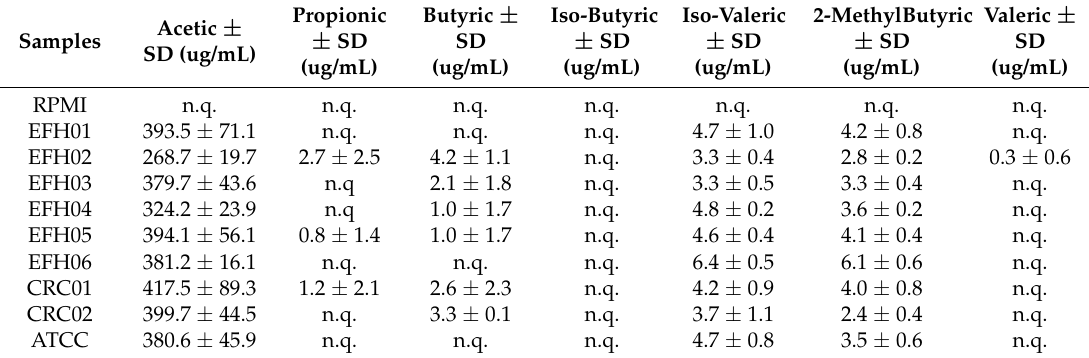
Table 4. Quantitative analyses of SCFAs in pre-fermented medium